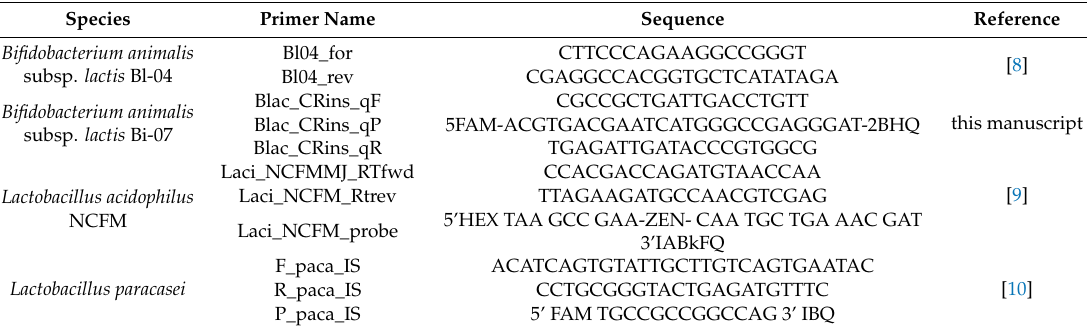
Table 1. qPCR assays used for bacterial